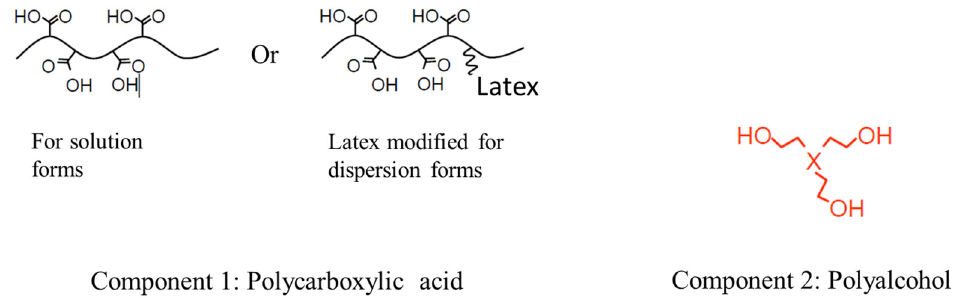
Figure 1. Polycarboxylic acid and polyalcohol components of the resin react at a temperature >130 °C in curing reaction to form a polyester [33].